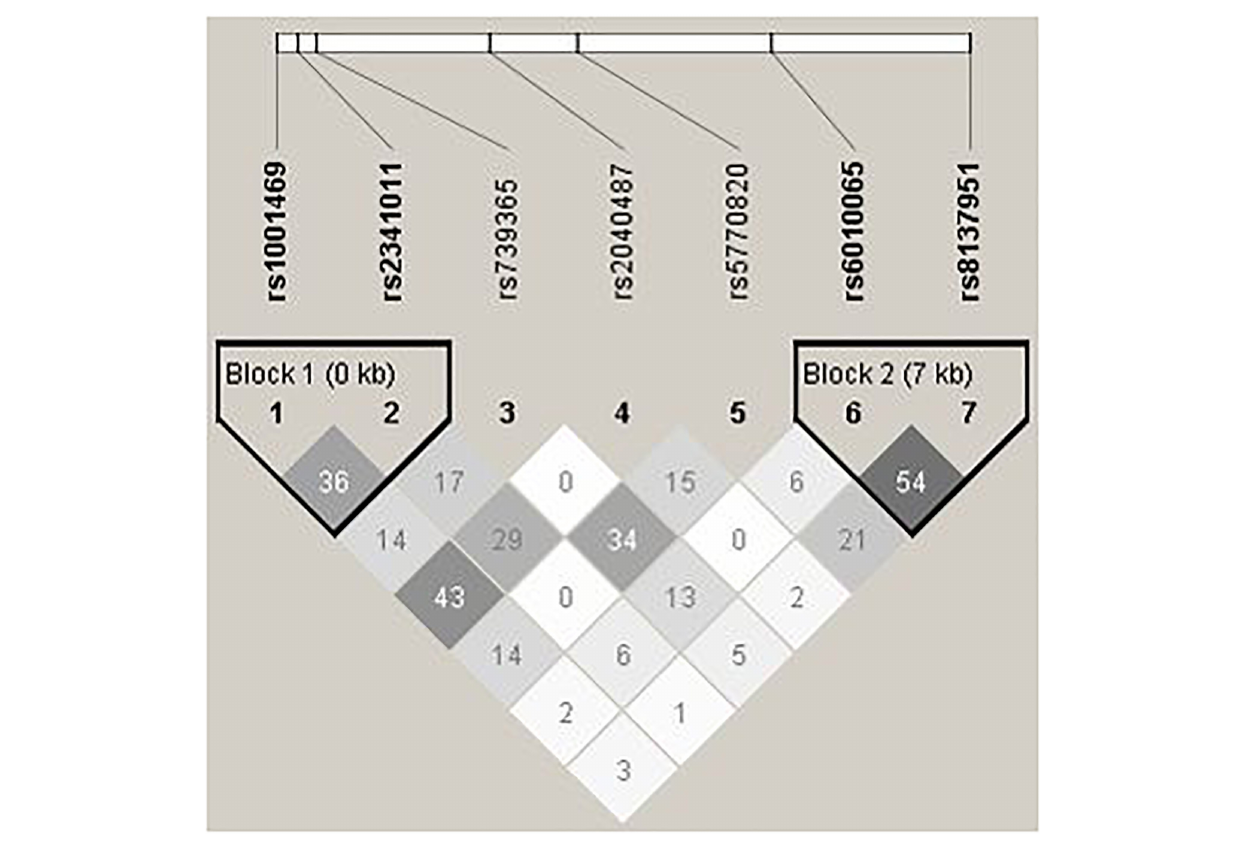
FIGURE 2 | Pair-wise LD structure of selected SNPs in SHANK3 . The graph represents the pair-wise LD structure of SNPs in SHANK3 ; the number in each cell is the R 2 between two SNPs with darker color representing stronger R 2 .